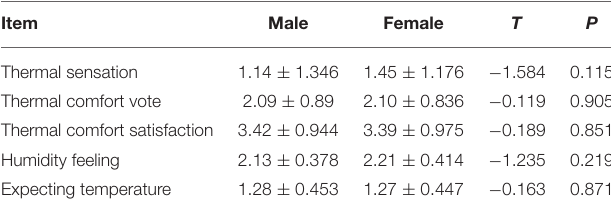
TABLE 4 | T -test for gender differences independent samples. Item